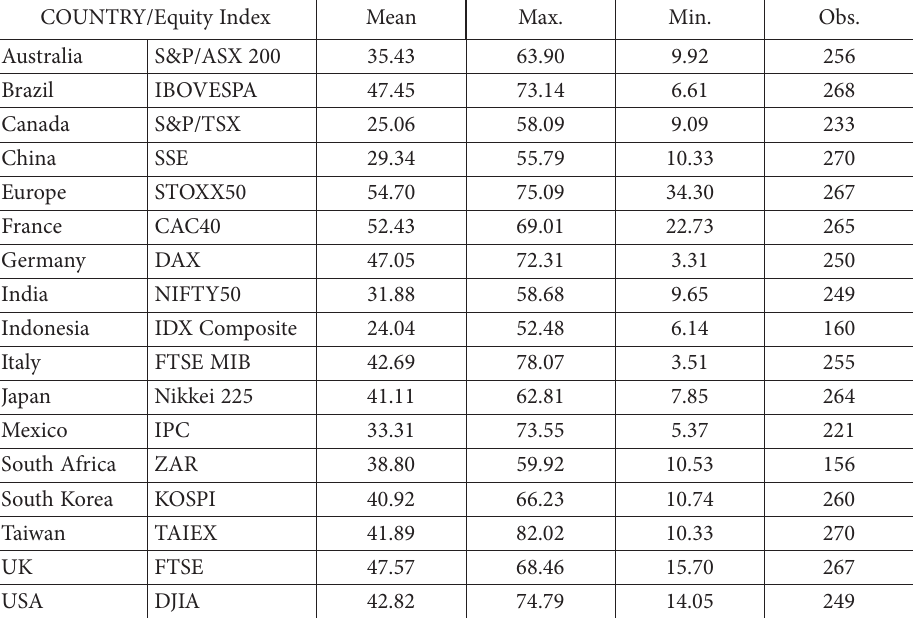
Table 1. Descriptive statistics – ESG reporting and score (source: author’s